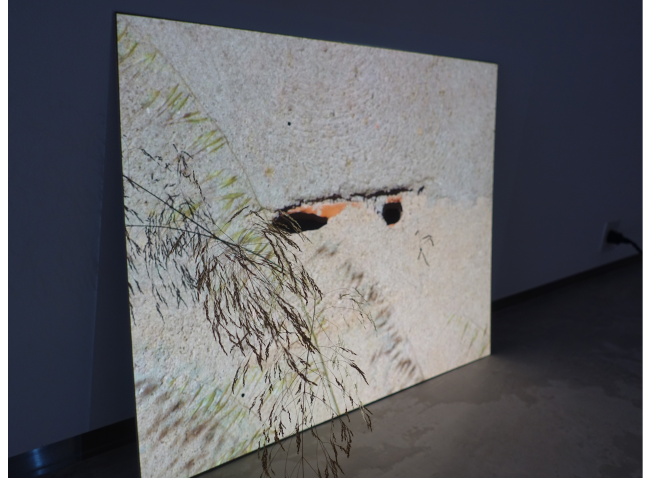
Figure 1: Video-installation IKEBANA (2016) by Alexandre Estrela. View from the private collection of Maria João and Armando